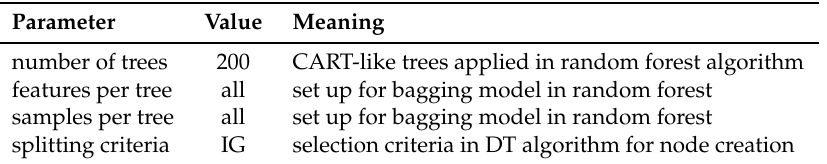
Table 3. Settings applied in RF classification.